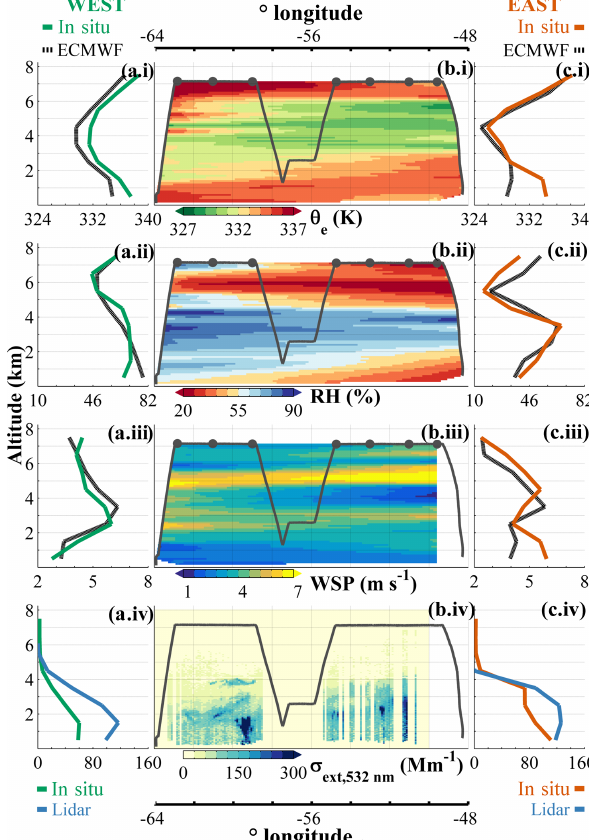
Figure 11. Summary of west to east regional gradient in equiva- lent potential temperature (i) , relative humidity (ii) , horizontal wind speed (iii) and aerosol extinction (iv) based on an east to west tran- sect (b) on 27 September 2012 (flight b743). The thermodynamic curtains (b.i–iii) are derived from linearly interpolated aircraft (grey line) and dropsonde (grey dots) profiles. The curtain of the lidar ex- tinction coefficient at 532nm (b.iv) is reproduced from Marenco et al. (2016) scaled from 355nm using a scaling factor of 0.57 follow- ing Marenco et al. (2014). The regional gradient is emphasised by the side panels which show the median thermodynamic and aerosol extinction profiles for all western (a) and eastern flights (c) . In panels (i) to (ii) the observed thermodynamic parameters are com- pared to ECMWF reanalysis data extracted along the flight paths. In panel (iv) the in situ aerosol scattering coefficient at 550nm is compared to the lidar extinction coefficient averaged over a simi- lar region (Fig. S6; NB both measurements are reported at ambient temperature and